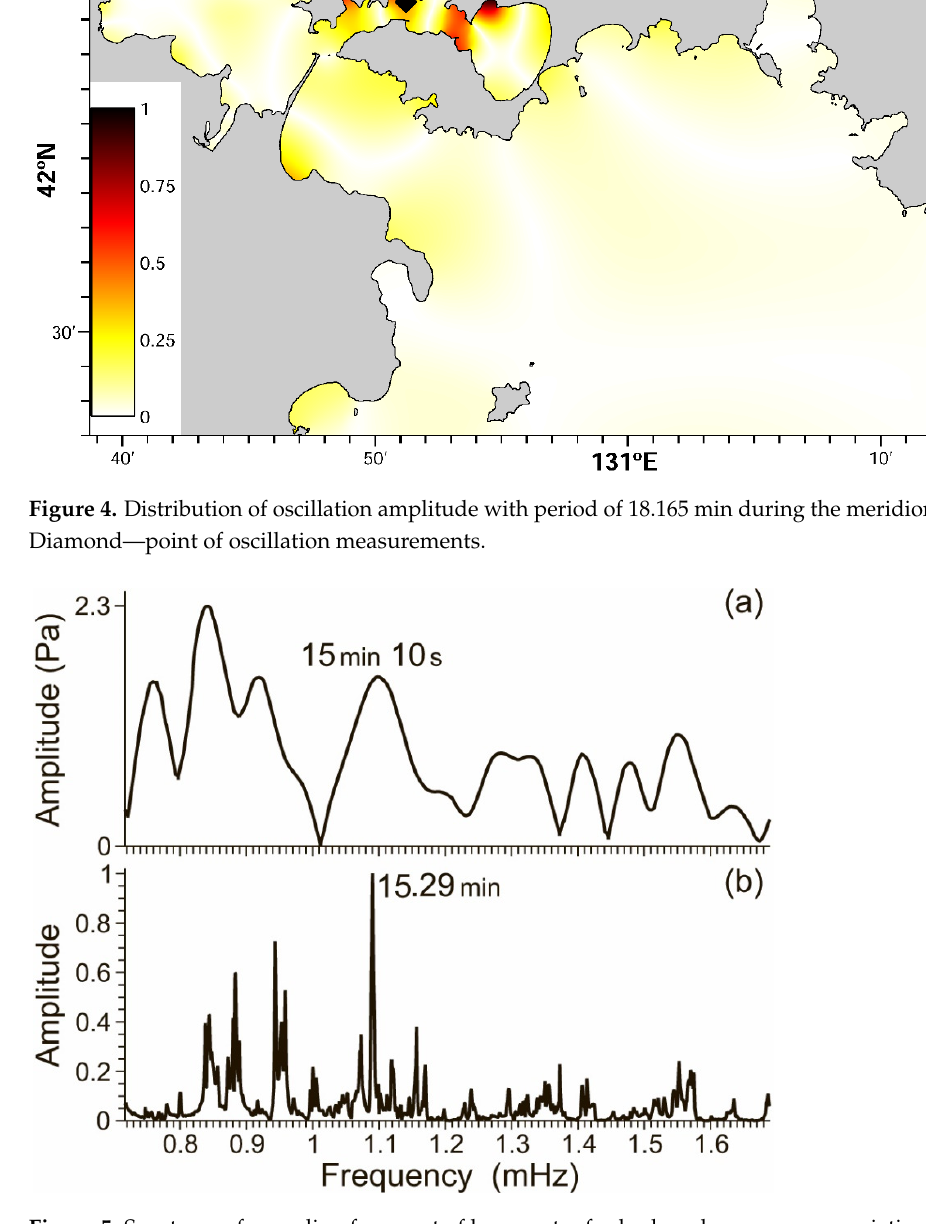
Figure 5. Spectrum of recording fragment of laser meter for hydrosphere pressure variations ( а ) and the resonance curve ( b ).